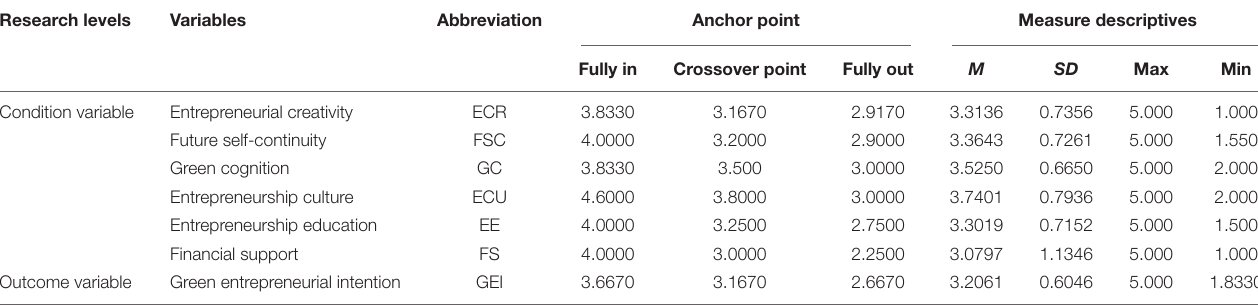
TABLE 2 | Each variable calibration anchor and sample descriptive statistics. Research